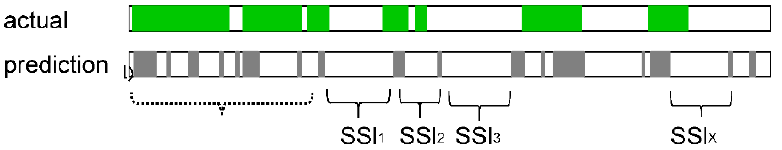
Figure 4. Sound to sound interval was calculated by the length between the end of the bowel sound and the start of the consecutive bowel sound. The green colored area in the top horizontal bar labeled “actual” shows the bowel sound length that have been manually labeled by human raters. The bottom one with gray colored area labeled “prediction” shows the bowel sound length that have been predicted by the models. The interval of the bowel sounds is used as an index called SSI.